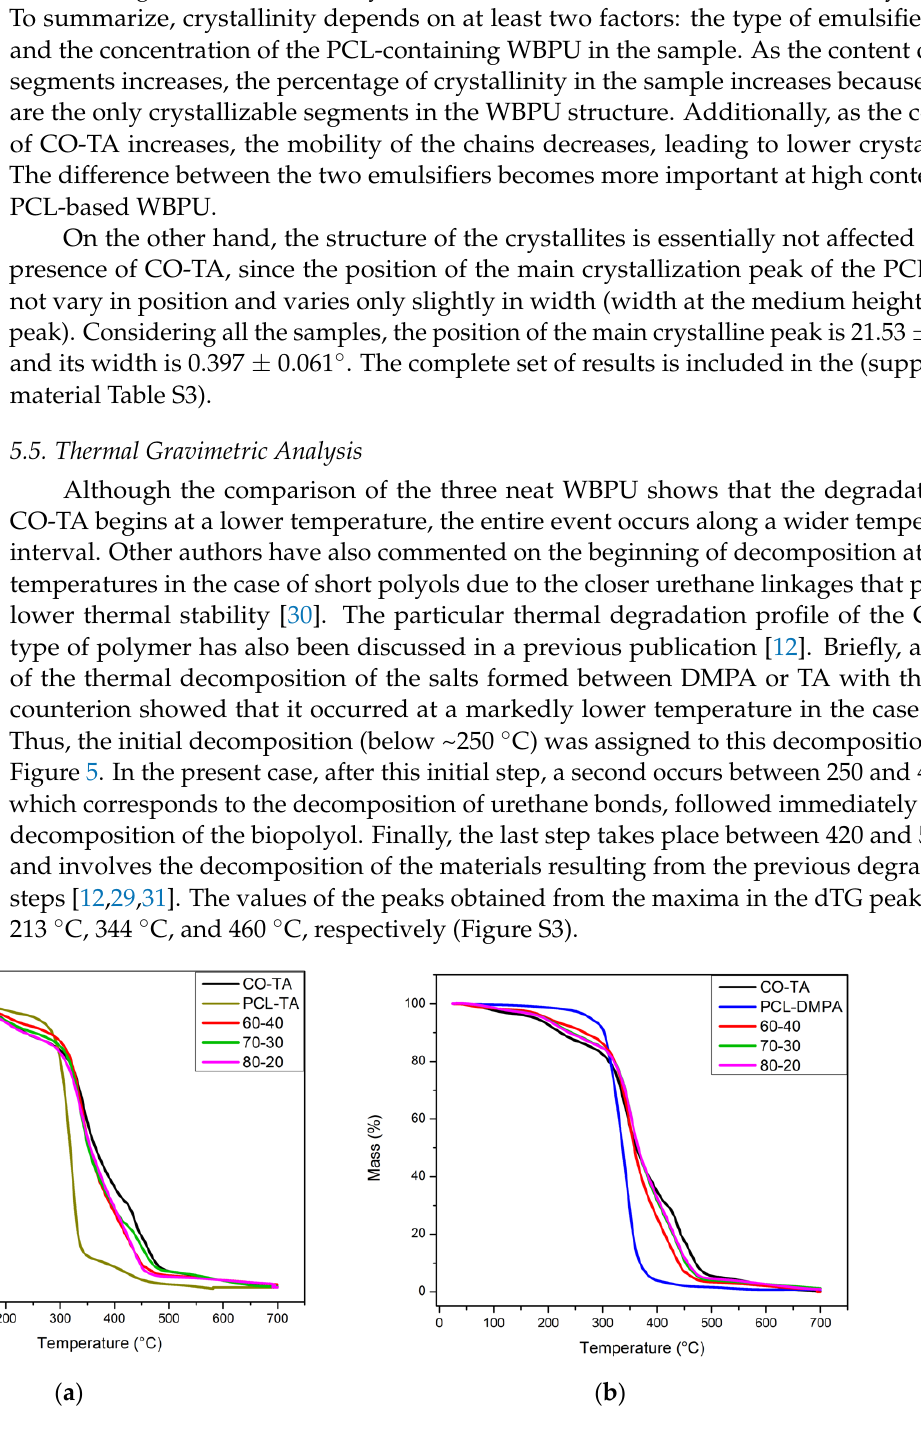
Figure 5. Thermogravimetric results for the hybrid films containing PCL-TA ( a ) and PCL-DMPA ( b ).